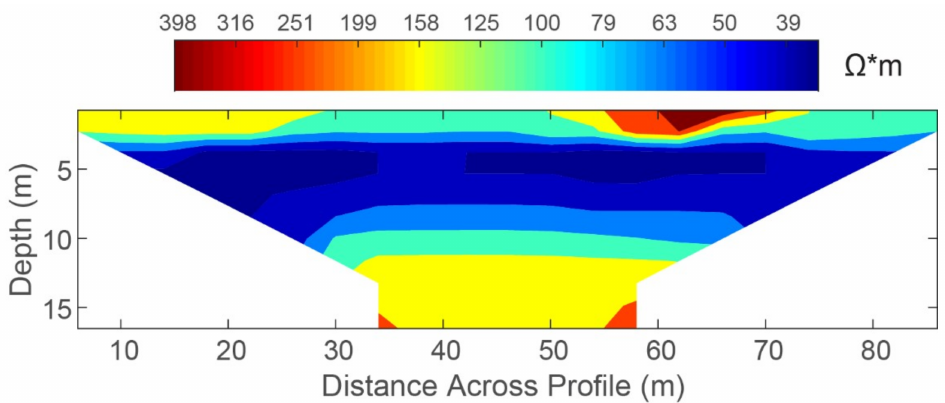
Figure 4. Inverted electrical resistivity tomography profile in Marian Meadow. Profile is on the southern side of Highway 36 (Figure 1B). Left side of profile strikes northeast. The profile consisted of 24 electrodes at a spacing of four-meters. The bottom corners (red color) of the model show small numerical artifacts of the inversion process, typical of electrical resistivity